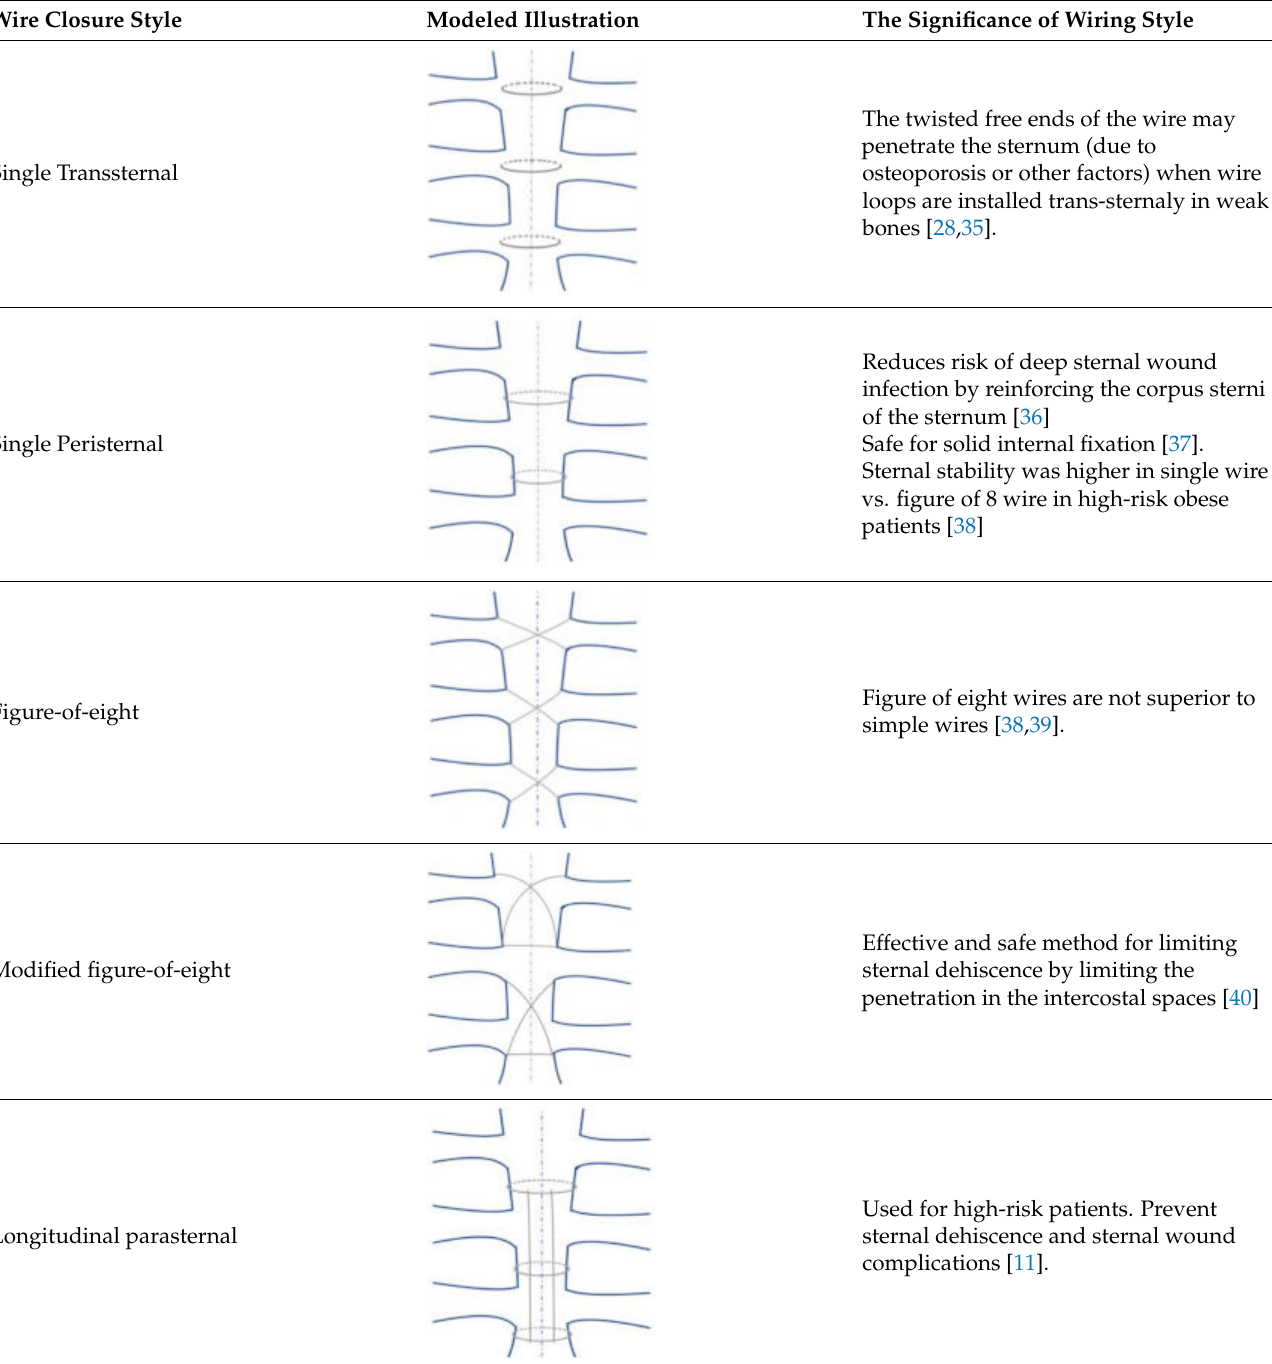
vs. figure of 8 wire in high-risk obese